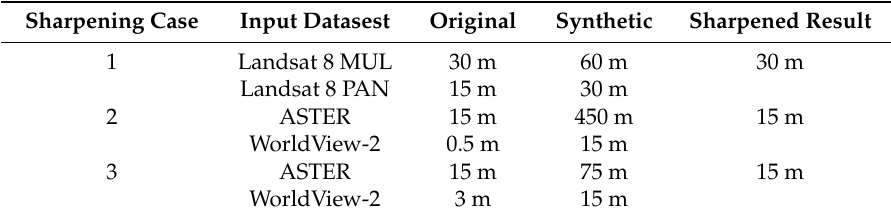
Table 3. Overview of input datasets for testing the synthesis property. Synthetic images were created in order to test the synthesis property of the fused image. Synthetic images were created to preserve the ratio between the original MUL and PAN images, when the PAN was synthetically degraded to the original resolution of the original MUL.